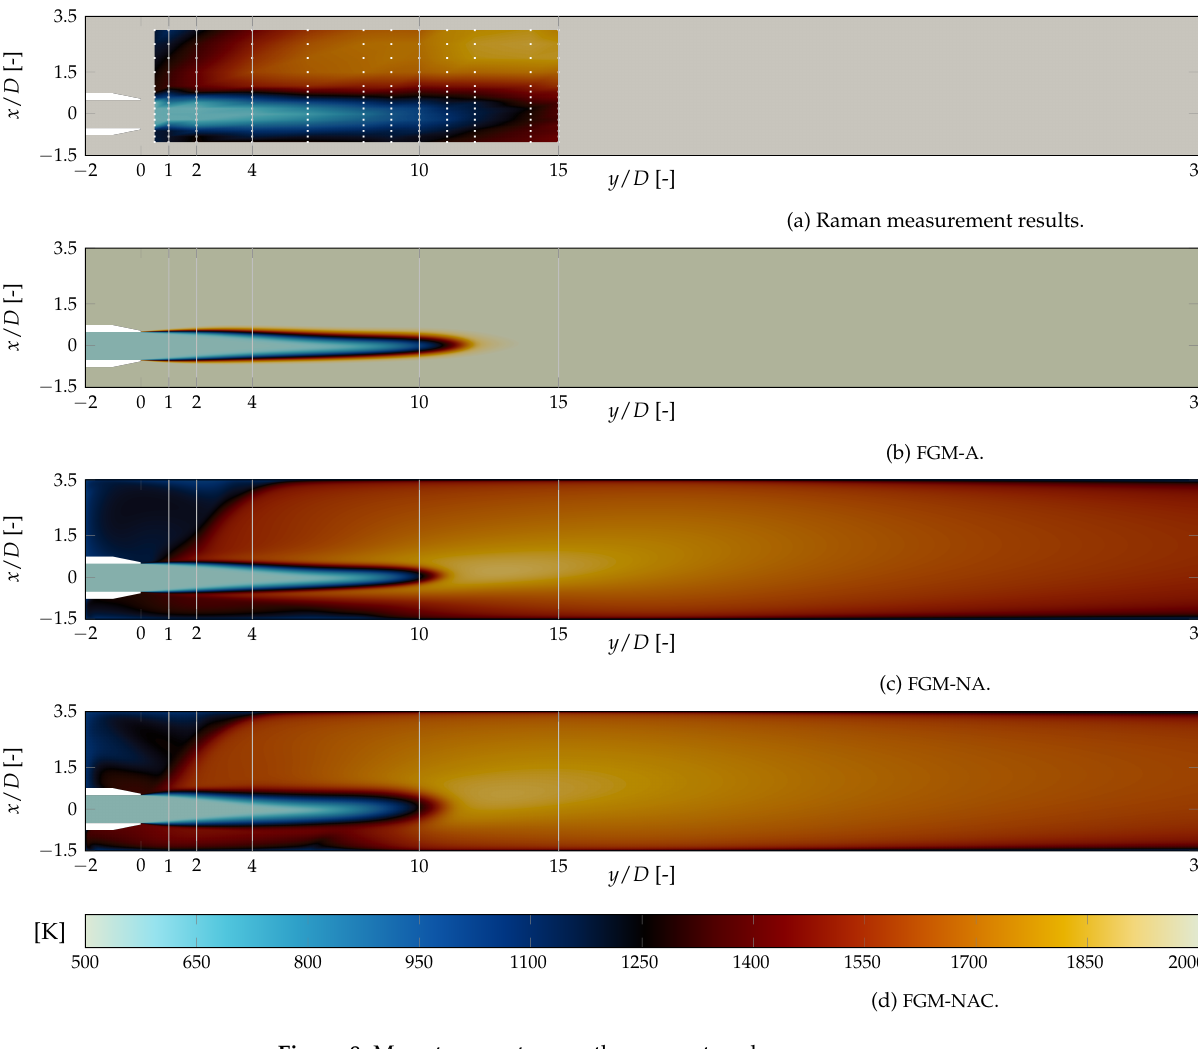
Figure 8. Mean temperature on the symmetry plane.